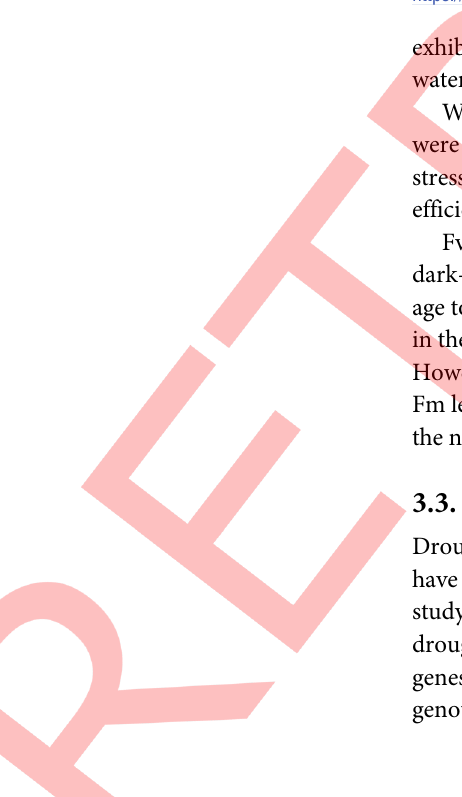
Fig 2. Abaxial stomata density in the four genotypes under drought stress conditions. Values represent means of n = 10 ± SEM (one way ANOVA).